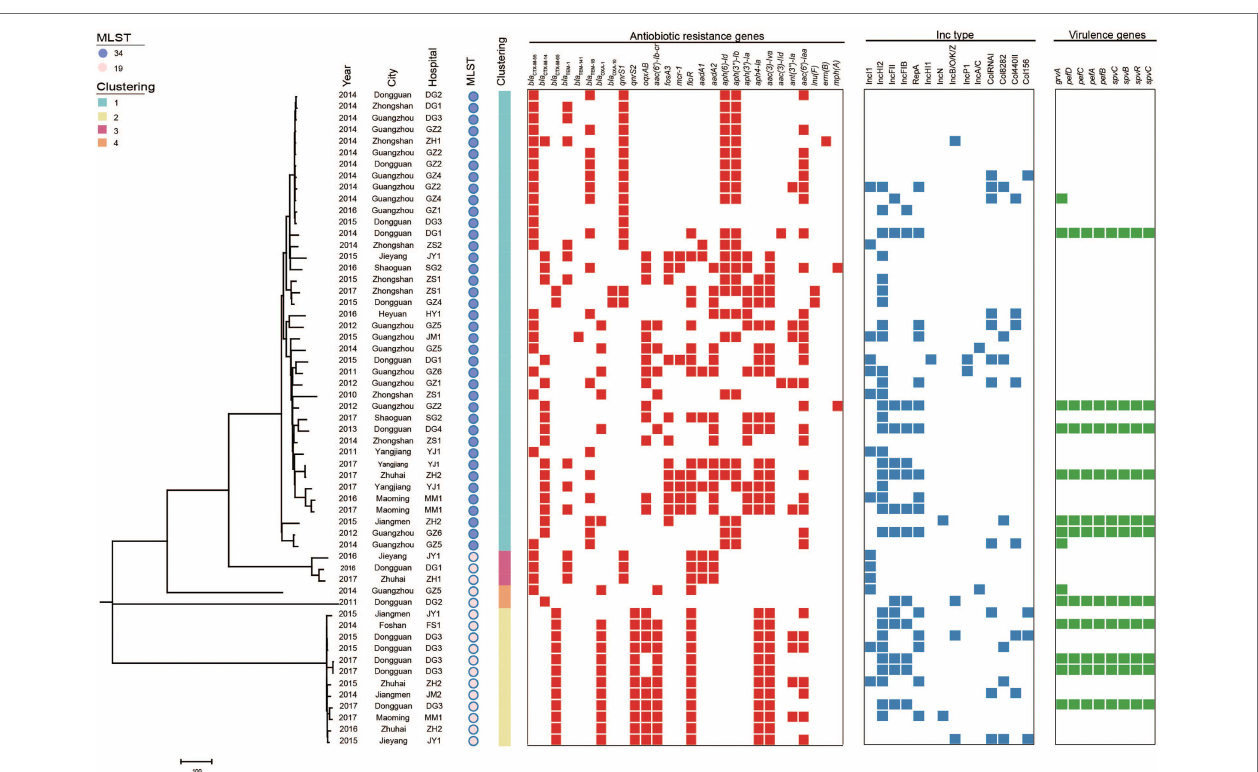
FIGURE 3 | Phylogenetic analysis of bla CTX-M -positive S. Typhimurium isolates in this study ( n = 57). Bayesian evolutionary tree was constructed using core-genome SNPs. Each isolate is labeled with the city of isolation year, hospital, ST and cluster. The red-filled squares indicate the possession of the indicated antimicrobial resistance genes (ARGs), the blue-filled squares indicate plasmid (Inc type), and the green-filled squares indicate virulence